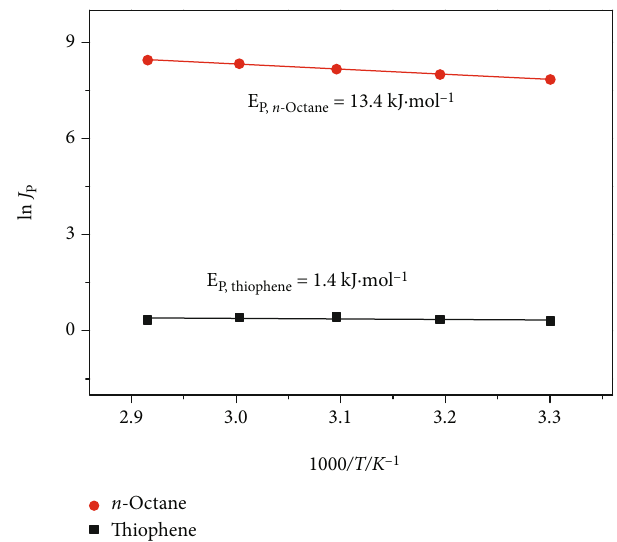
Figure 13: Arrhenius plots of thiophene and n -octane fl uxes as a function of feed